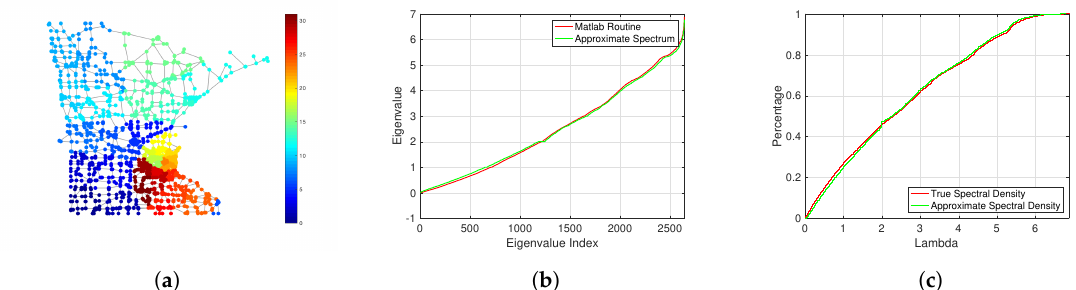
Figure 6. Illustration of the method for the Minnesota graph, a close-to-planar graph. ( a ) Comparison of the true (red) and approximate (green) spectrum of its Laplacian matrix. ( b ) Comparison of the true (red) and approximate (green) cumulative spectral density of the Laplacian spectrum. ( c ) Minnesota graph with partition obtained by the graph separator.